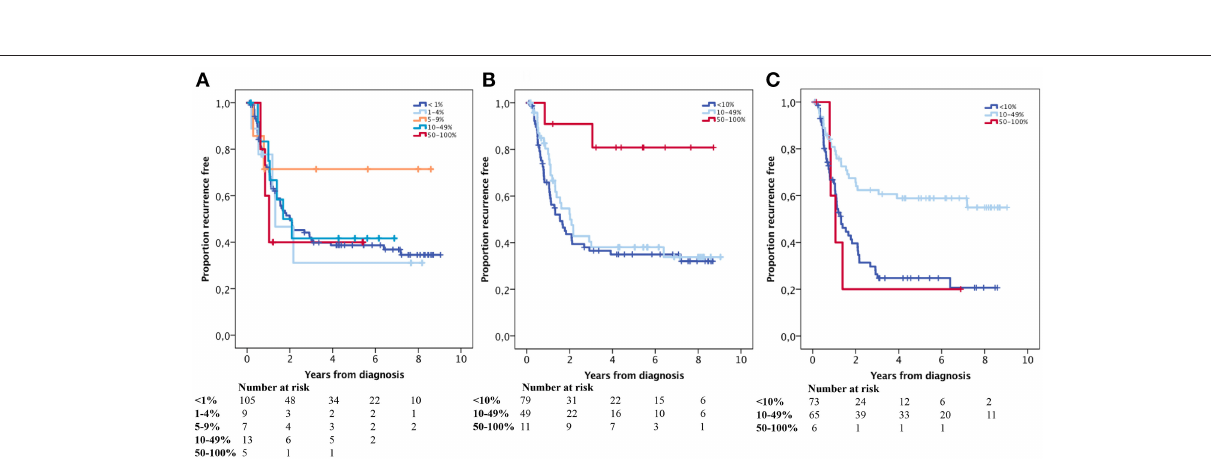
FIGURE 4 | Kaplan-Meier estimates of TTR in strata according to immunohistochemical staining categories of (A) PD-L1 expression on, (B) PD-L1 expression on and (C) PD-1 expression on in the entire cohort. (A) < 1% = ref, 1–4% p = 0.803, 5–9% p = 0.244, 10–49% p = 0.815, 50–100% p = 0.603, (B) < 10% = ref, 10–49% p = 0.484, 50–100% p = 0.010, (C) < 10% = ref, 10–49% p = 0.000, 50–100% p =